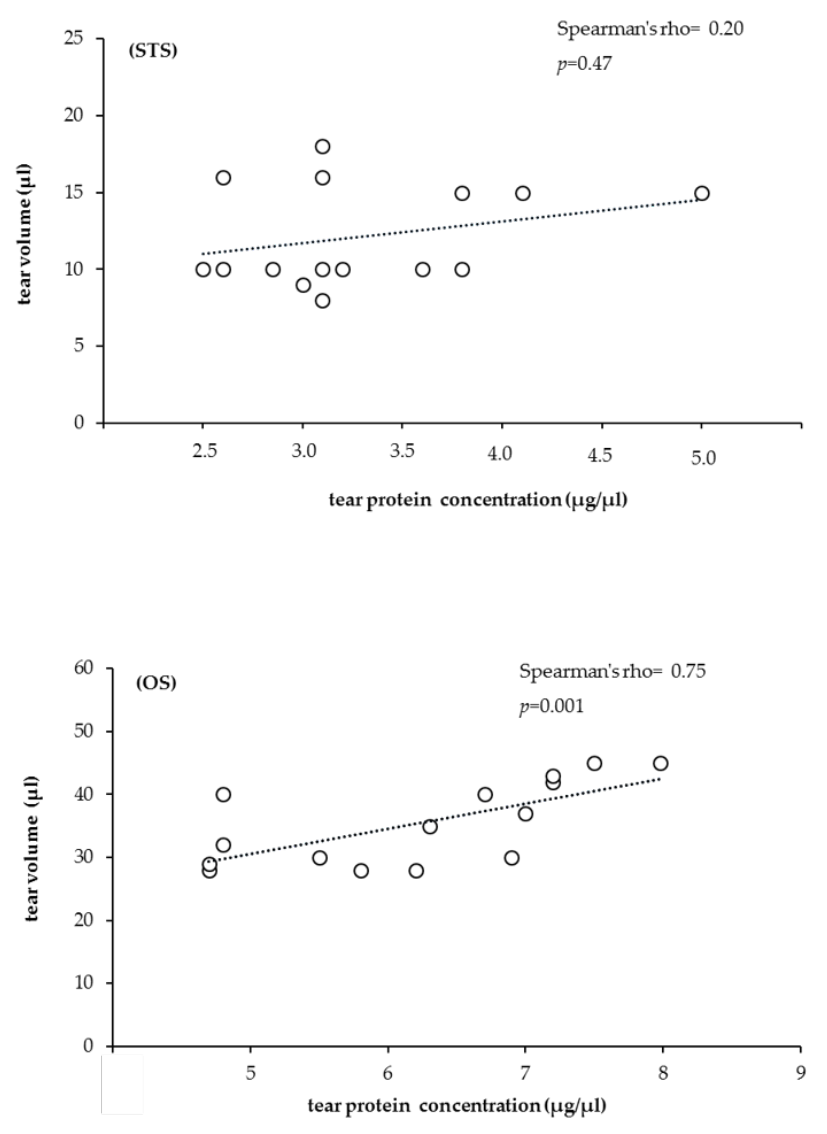
Figure 5. Spearman’s rank correlations testing for tear volume ( µ L) and concentration ( µ g / µ L) of tear samples collected by STS ( A ) and OS ( B